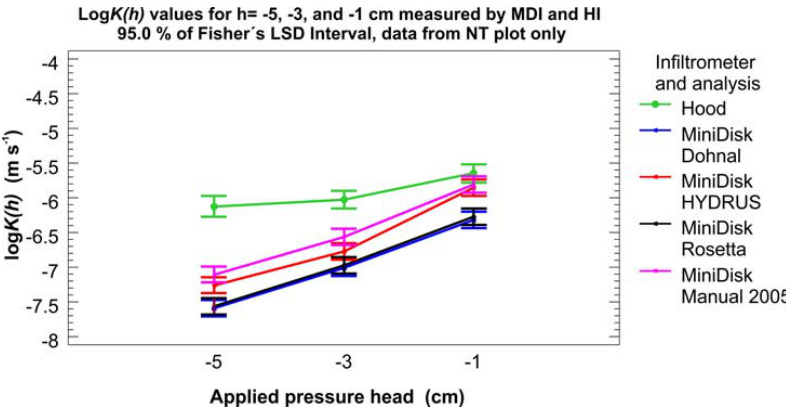
Figure 5. ANOVA results for log K ( h ) data measured by MDI and HI without the influence of soil treatment (data from NT only). NT is representing No-tillage treatment of soil.